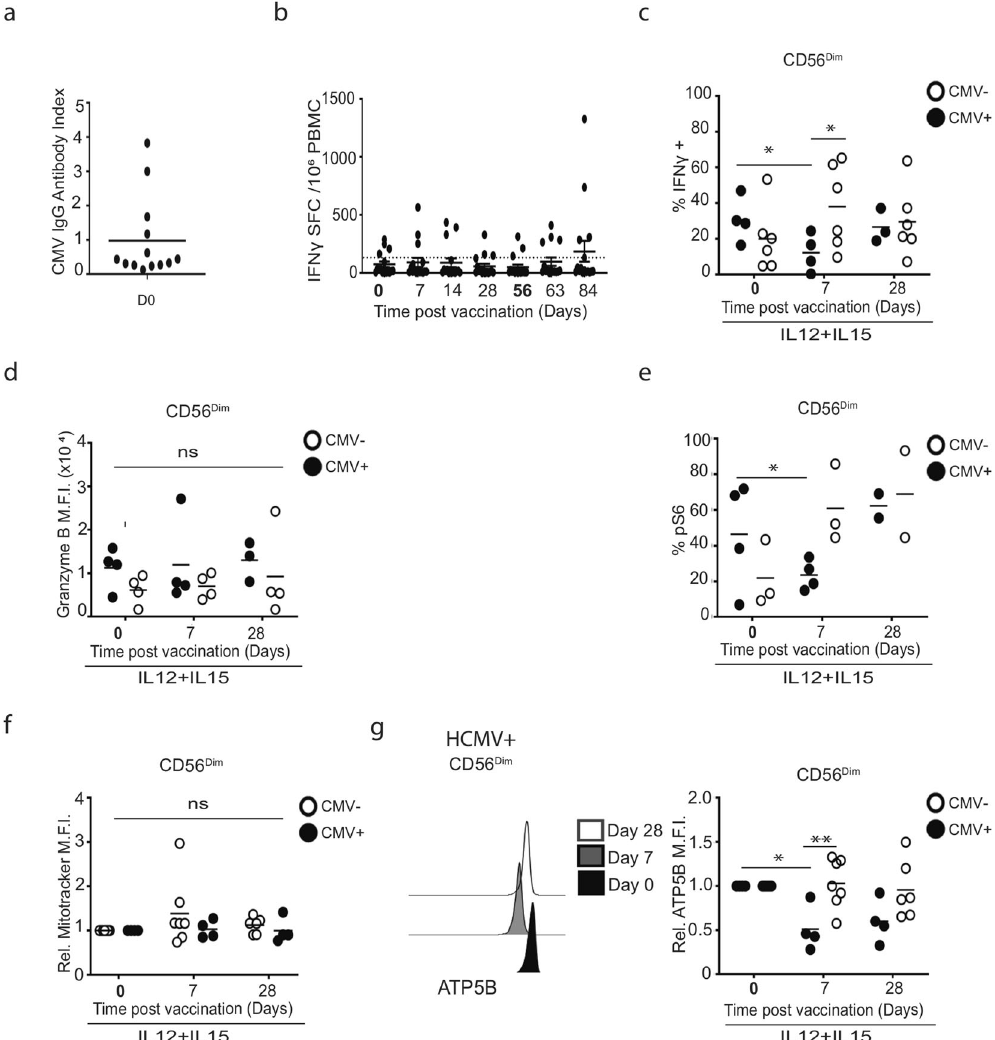
result ( n = 13). b PBMC ex vivo ELISPOT responses to HCMV lysate at baseline and after vaccination. c – e Strati fi cation of vaccine recipient responses based on HCMV seropositive (black circle) or negative (open circle) status. Each dot shows NK cells stimulated with IL-12/IL-15 overnight and measurement of NK cells expressing c IFN γ , d granzyme B and e pS6 for CD56 dim NK cells for pre- and post vaccination (Days 7 and 28). (HCMV − , n = 6 for c , d , n = 3 for e , HCMV + , n = 4). f Summary graphs of post-vaccination relative fl uorescence intensity of Mitotracker CMXRos and g ATP5B in NK cells from HCMV serodiscordant donors normalised to baseline (Day 0) values ( n = 7 HCMV − , n = 4 HCMV + ). Representative histogram of ATP5B post vaccination. Samples were compared by two-way ANOVA with Sidek ’ s post hoc test. n.s. not signi fi cant, * p < 0.05 and ** p <